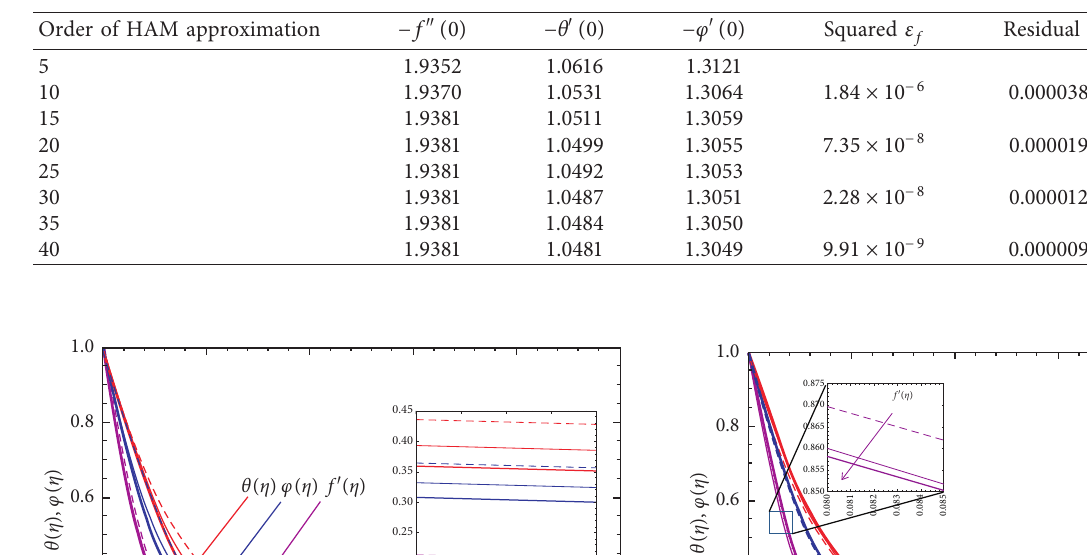
Table 1: Convergence of some HAM